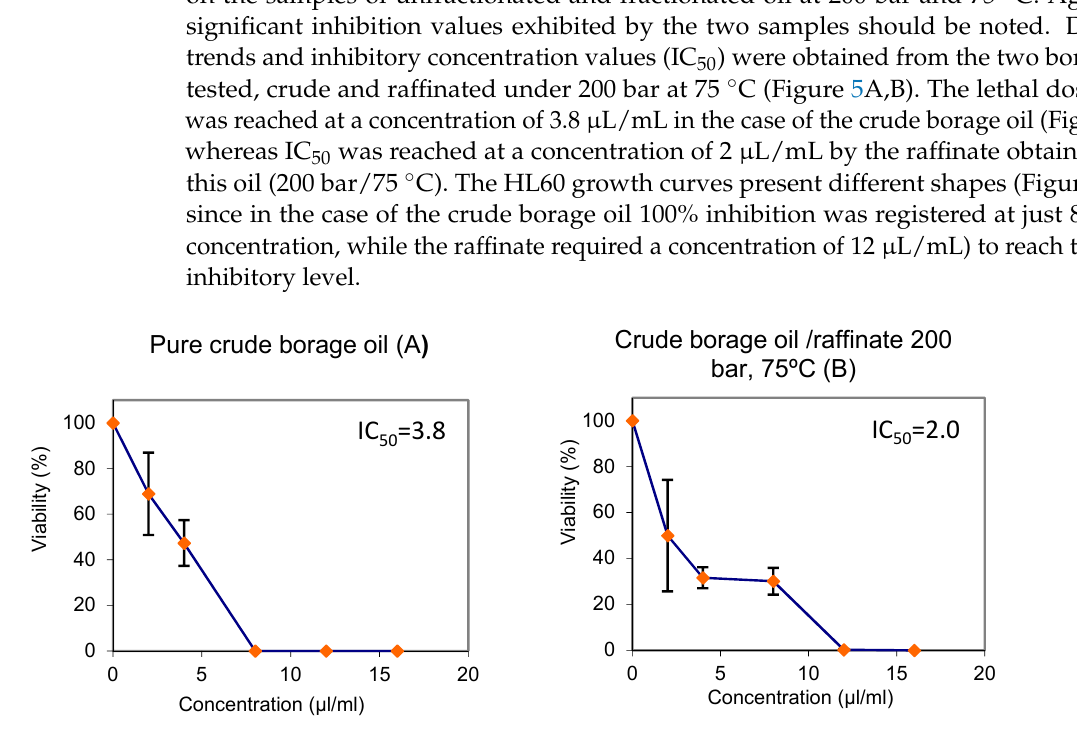
Figure 5. Viability of HL60 cells treated for 72 h either with pure crude borage oil ( A ) or with raffinate borage oil ( B ). The curves represent the percentages with respect to the results obtained from three independent experiments on the control substance (mean ± SD).